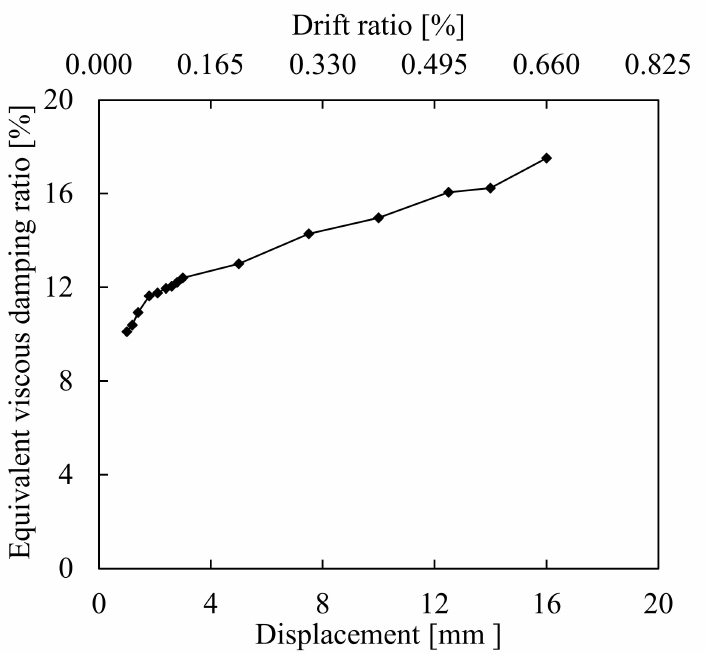
Figure 27. Equivalent viscous damping ratio versus displacement curve of the tested PCSP-ISF